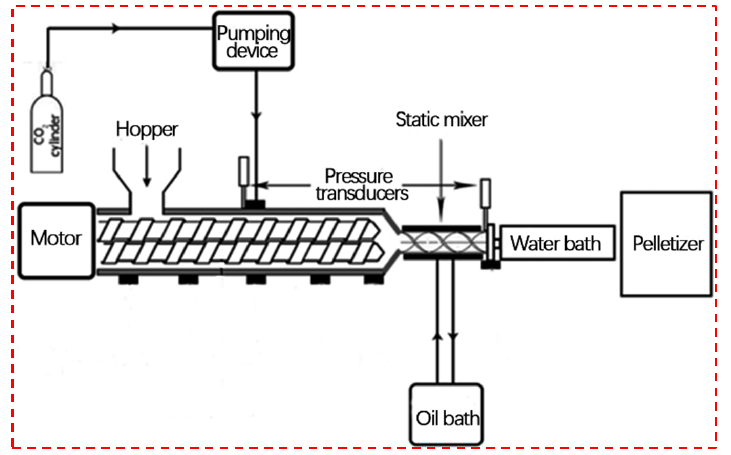
Figure 4. Principle of extrusion foaming process (reproduced with permission from Reference [73], Copyright 2021 Elsevier).